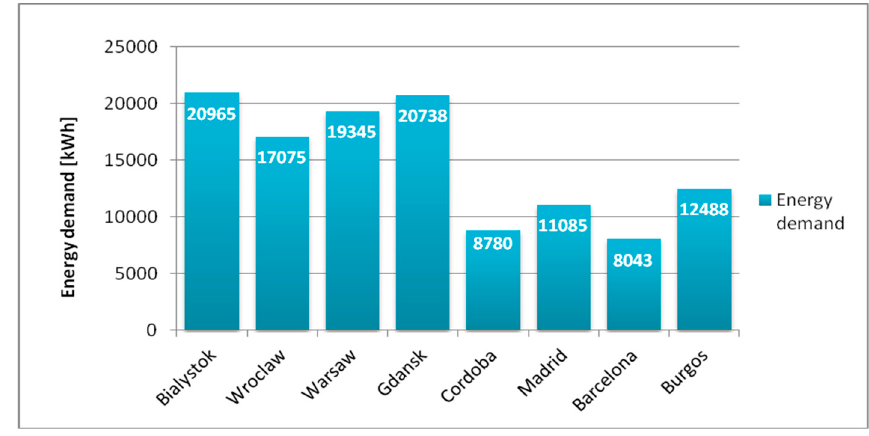
Figure 2. Comparison of the energy demand in different